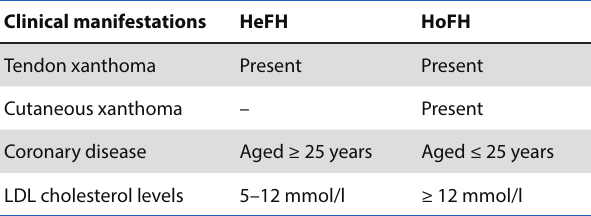
Table 1: A comparison of heterozygous versus homozygous clinical manifestations of familial hypercholesterolaemia 6 Clinical